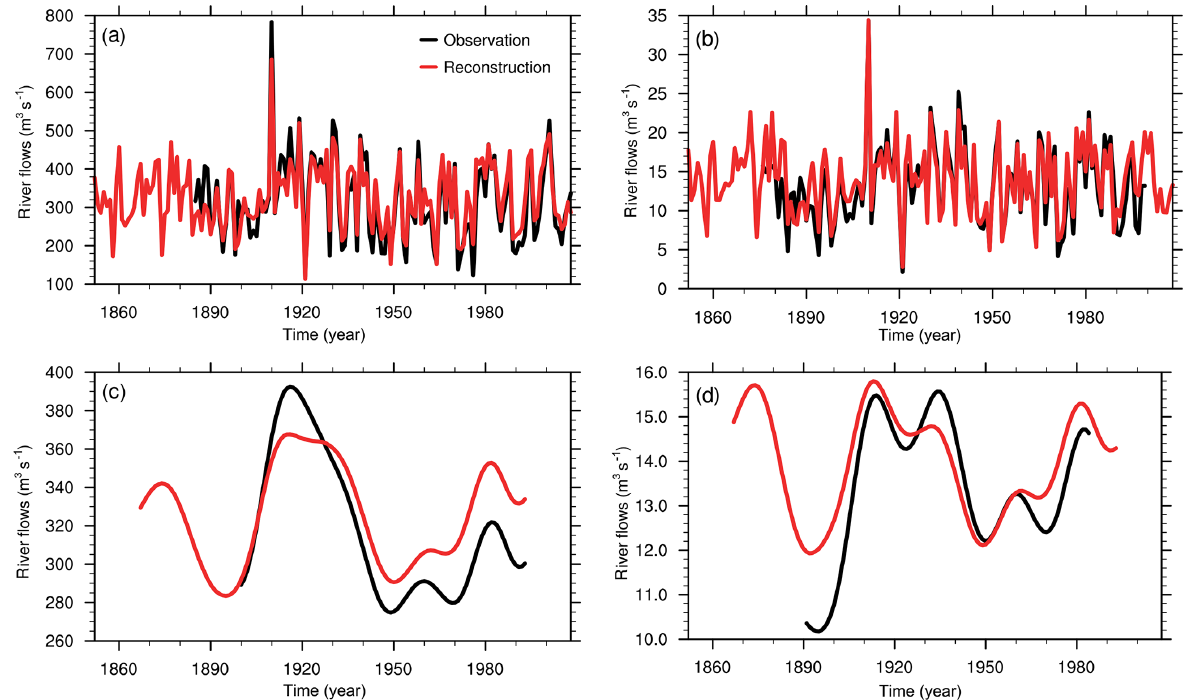
Figure 4. Annual series of river flows for (a) the Seine at Paris and (b) the Armançon at Aisy-sur-Armançon (see Fig. 1). (c, d) Annual low-pass-filtered series of river flows for the same stations as panels (a) and (b) . Black: observations. Red: Seine